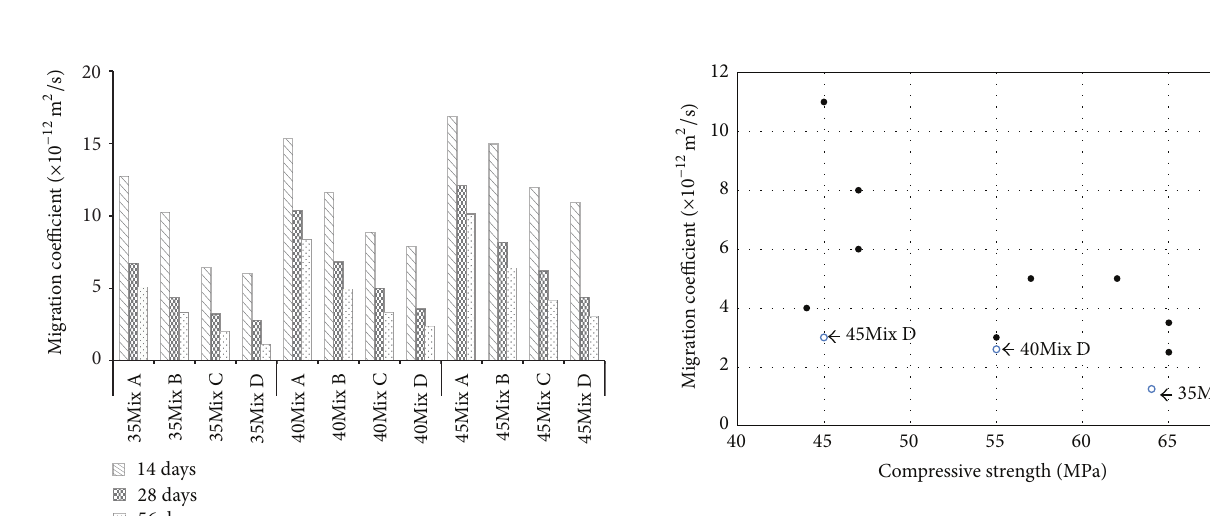
Figure 12: Chloride migration coefficient.